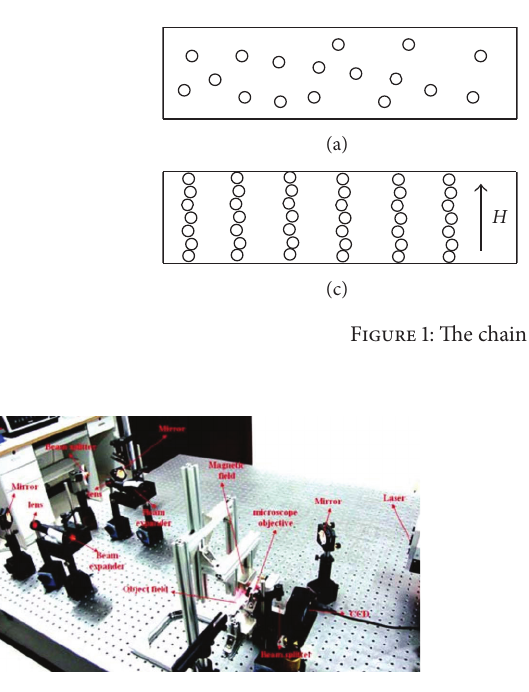
Figure 2: The experimental device of measurement of MR fluids by digital